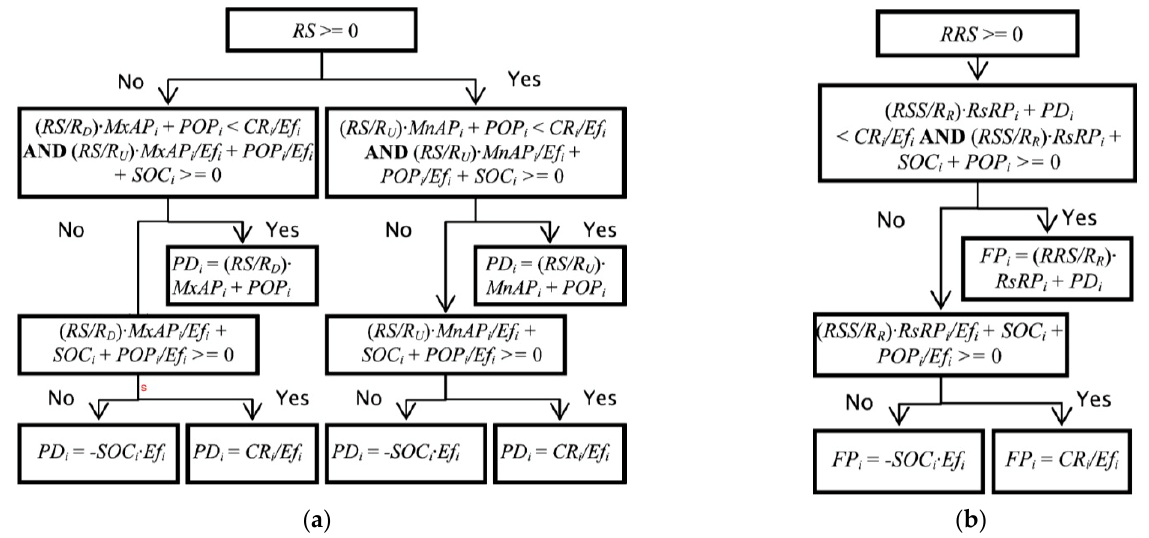
Figure 1. ( a ) Relationship between preferred operating point and ancillary services capacities (battery power draw); ( b ) Relationship between preferred operating point and ancillary services capacities (battery power